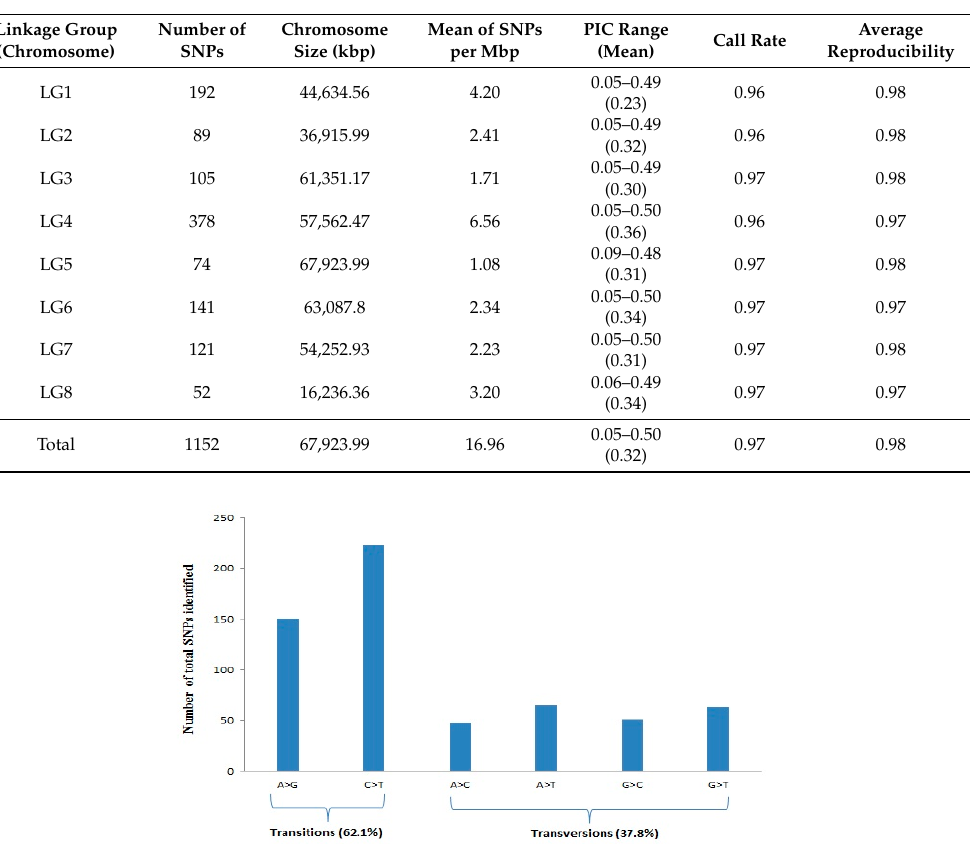
Table 1. Polymorphism information content (PIC), call rate, average reproducibility, and distribution of DArTseq-SNPs on chickpea chromosomes.